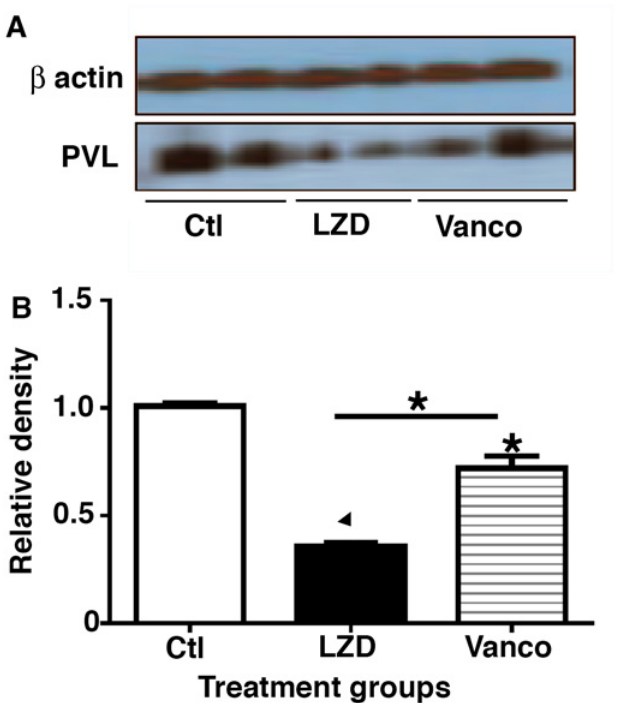
Figure 6. LZD decreased PVL toxin levels in lungs post bacterial challenge as compared to Vanco or saline treated animals. WT mice were infected with H1N1 100 pfu i.n. and on day 7 challenged with 5×10 7 cfu cMRSA i.t., infected mice were treated with either vehicle or antibiotics LZD (80mg/kg i.p.) or Vanco (110 mg/kg i.p.). Lungs were harvested 24 hours post bacterial challenge and homogenized to single cell suspension, PVL protein levels were measured by western blot analysis and densitometry using Image J software. n = 4 in each group, experiments repeated twice. * p < 0.05, τ < 0.001 as compared to vehicle treated